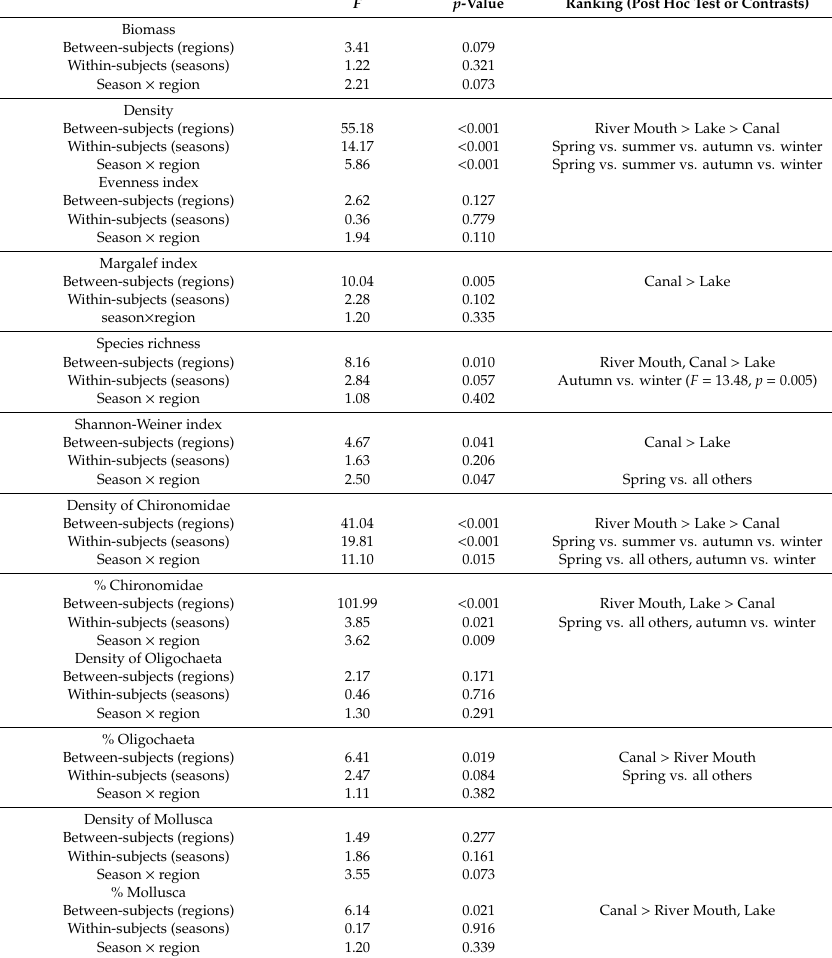
Table 3. Repeated measured ANOVAs of e ff ects of regions in four seasons on biomass, density, diversity indices (Shannon-Weiner, richness, evenness, Margalef) and the density and relative abundance of main groups (Chironomidae, Oligochaeta, Mollusca). p -values < 0.05 are in bold.